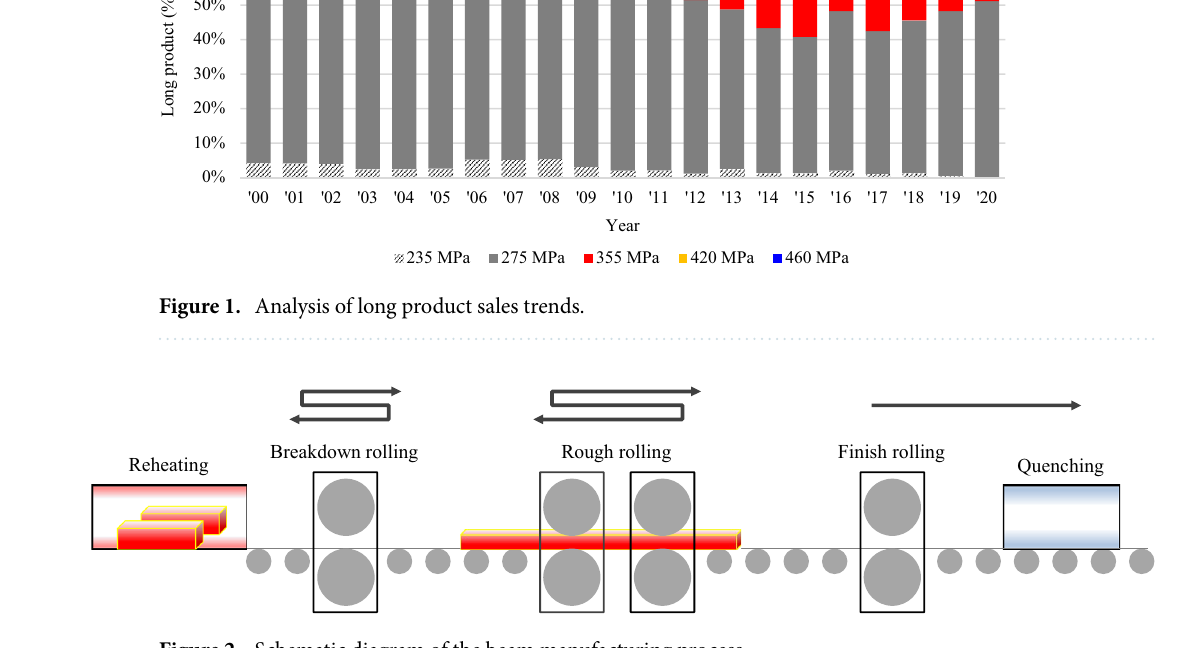
Figure 2. Schematic diagram of the beam manufacturing